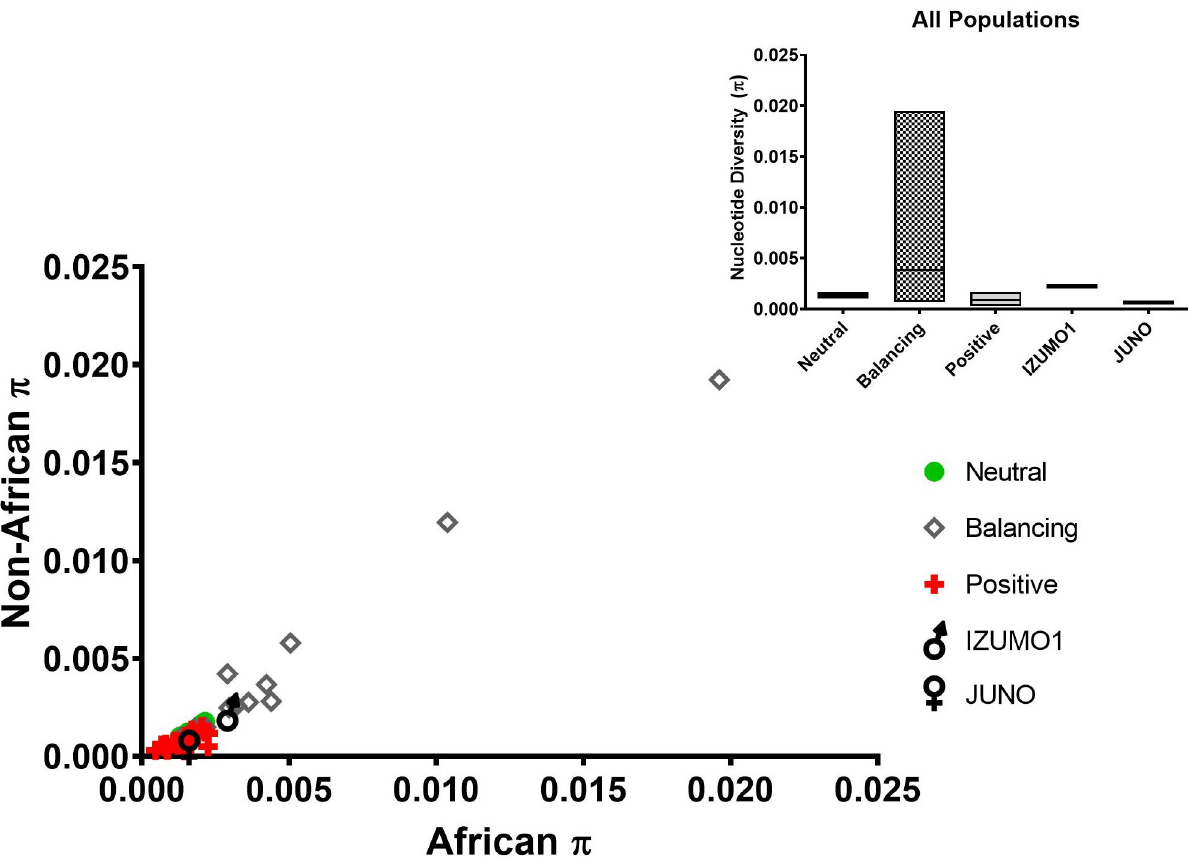
Fig 3. A comparison of the nucleotide diversity ( π ) values of genes believed to be under, neutral evolution (circles), balancing (diamonds) or positive (crosses) selection. IZUMO1 and JUNO are represented by the traditional male and female symbols, respectively. The mean (bar) values for all populations combined are shown in the insert within maximum and minimum value